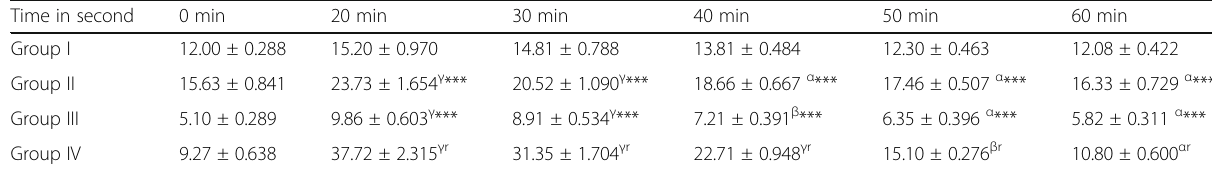
Table 6 The effect of long term exposure of Momordica charantia on GLP-1 level in normal and diabetic rats Time in